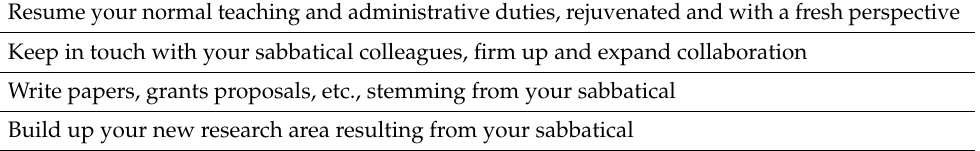
Table 5. After your